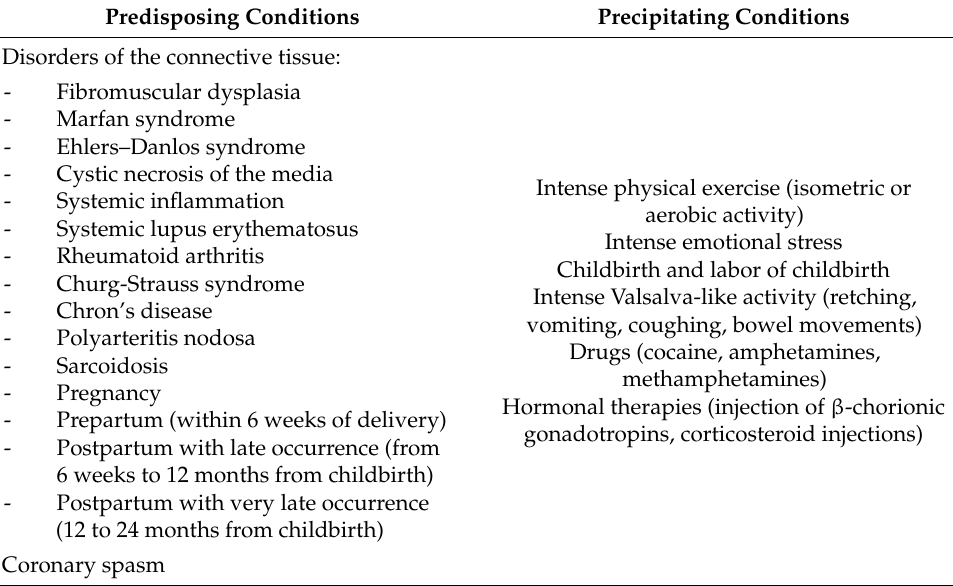
Table 1. Predisposing and precipitating conditions of spontaneous coronary artery dissection adapted from